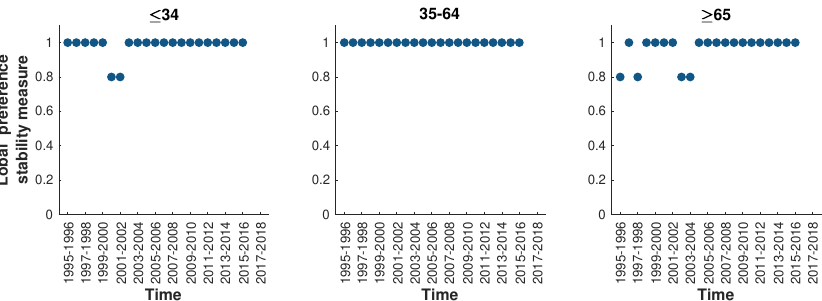
Figure A5. Graphic illustration of the local decision stability measures obtained for each age group for Question 1. Table A4. Temporal preferences established by Healthcare Spanish Barometer attending to different age ranges for Question 1.